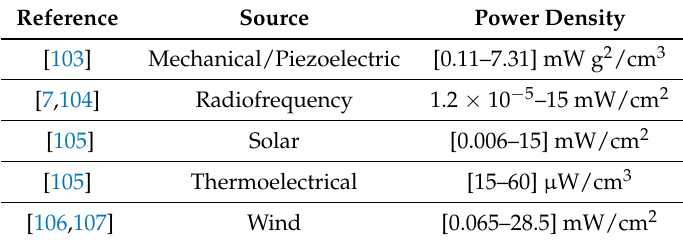
Table 2. Power density of various